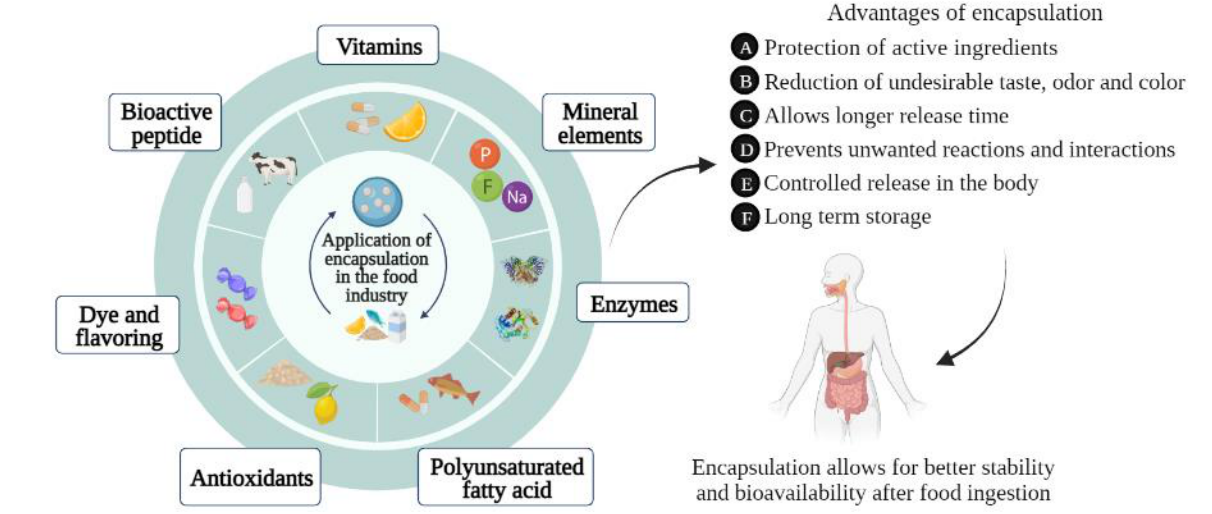
Figure 4. Advantages and applications of encapsulation in the food area.